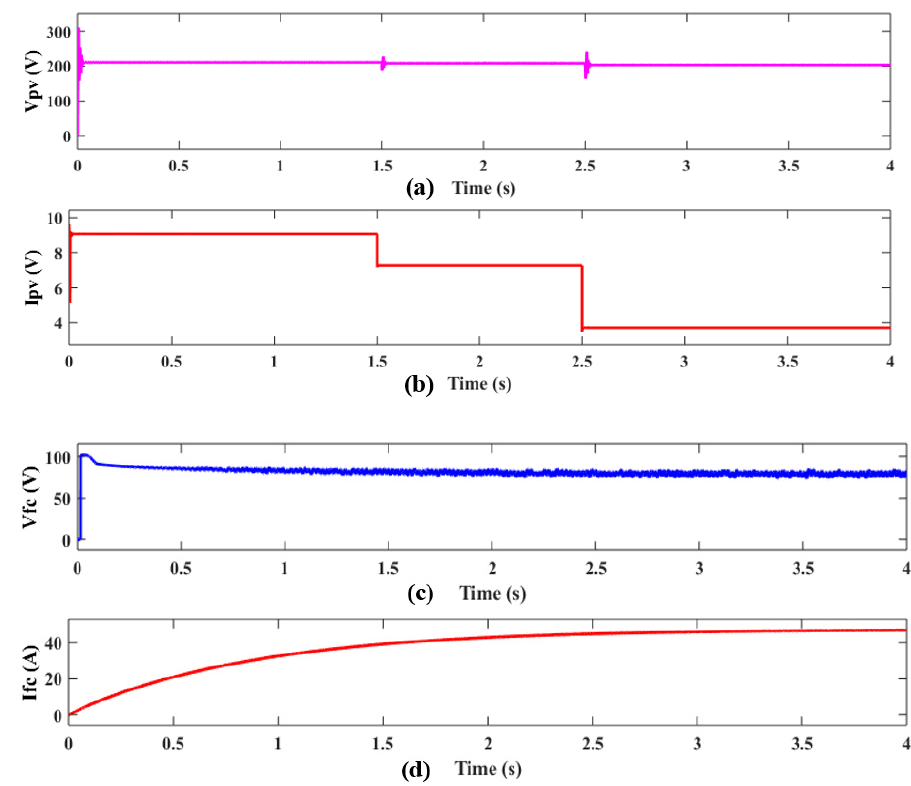
Figure 13. MPPT with trapezoidal MF—( a ) PV voltage ( b ) PV current ( c ) Fuel cell current ( d ) Fuel cell voltage.